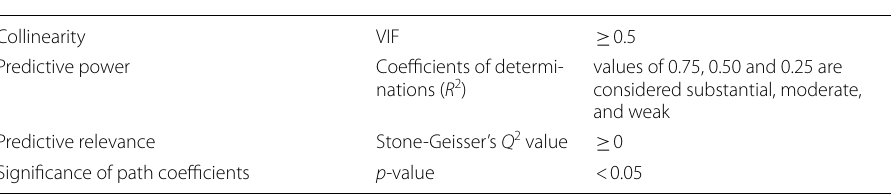
Source: authors’ work based on Hair et al. (2017)